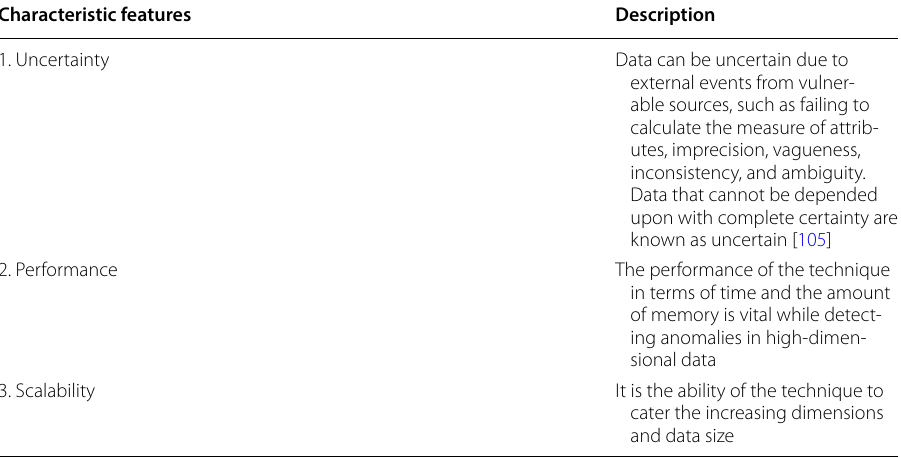
Table 4 Challenges of anomaly detection in context of big data problem (volume aspect) Characteristic